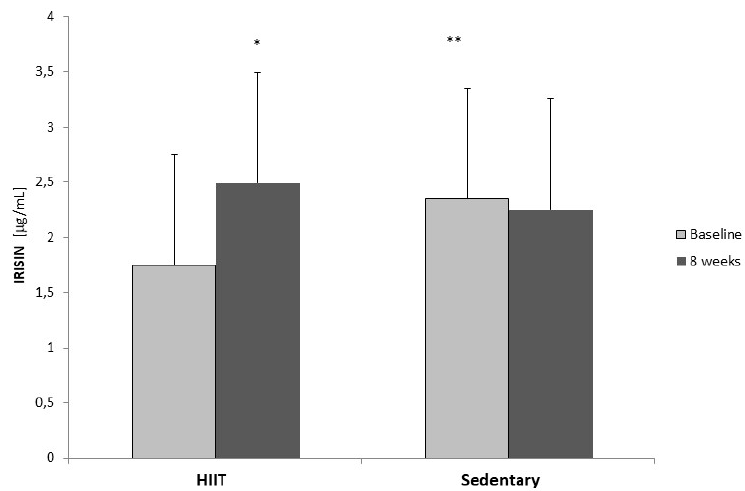
Figure 4. Irisin level in HT and sedentary group at the baseline and after eight weeks; * p < 0.05 in comparisontobaselinevalue: ** p <